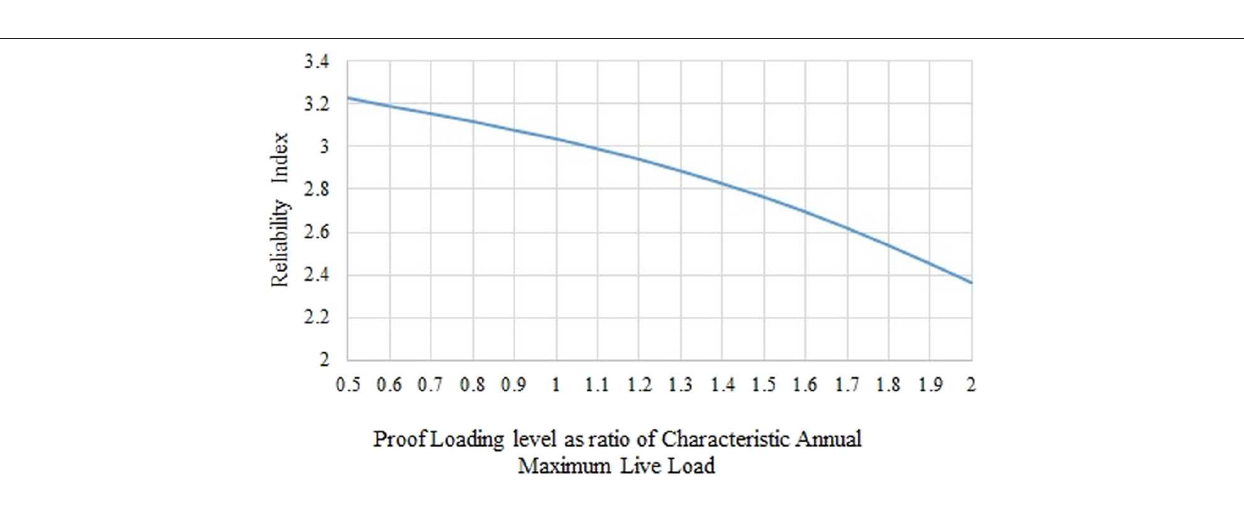
The expected utility is calculated with the aggregation of the expected costs from the structural performance over the remaining service life of the bridge (the costs are modeled as negative utilities). The total expected costs over the remaining